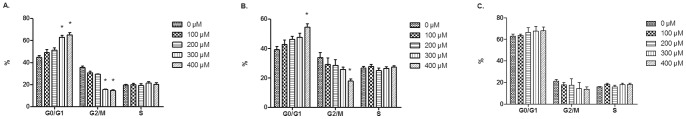
The result of cell cycle distribution.The cell cycle distribution was detected by flowcytometry. (A,B)The proportion of G0/G1 phase cells increased and G2/M phase cells decreased in 5-8F and CNE2 cell lines as I3C concentration increased. (C)The proportion of all phase cells barely elevated in 16HBE cell line as I3C concentration increased. The data are presented as the mean± SEM. *p<0.05, compared to the proportion of each phase cells in 0 µM I3C treatment.